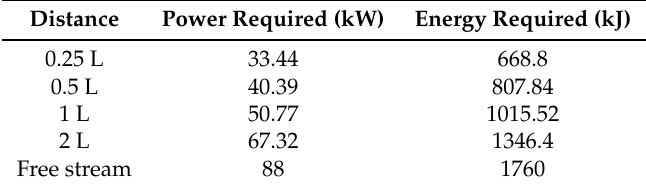
Table 6. Energetic parameters required to overcome the air resistance.